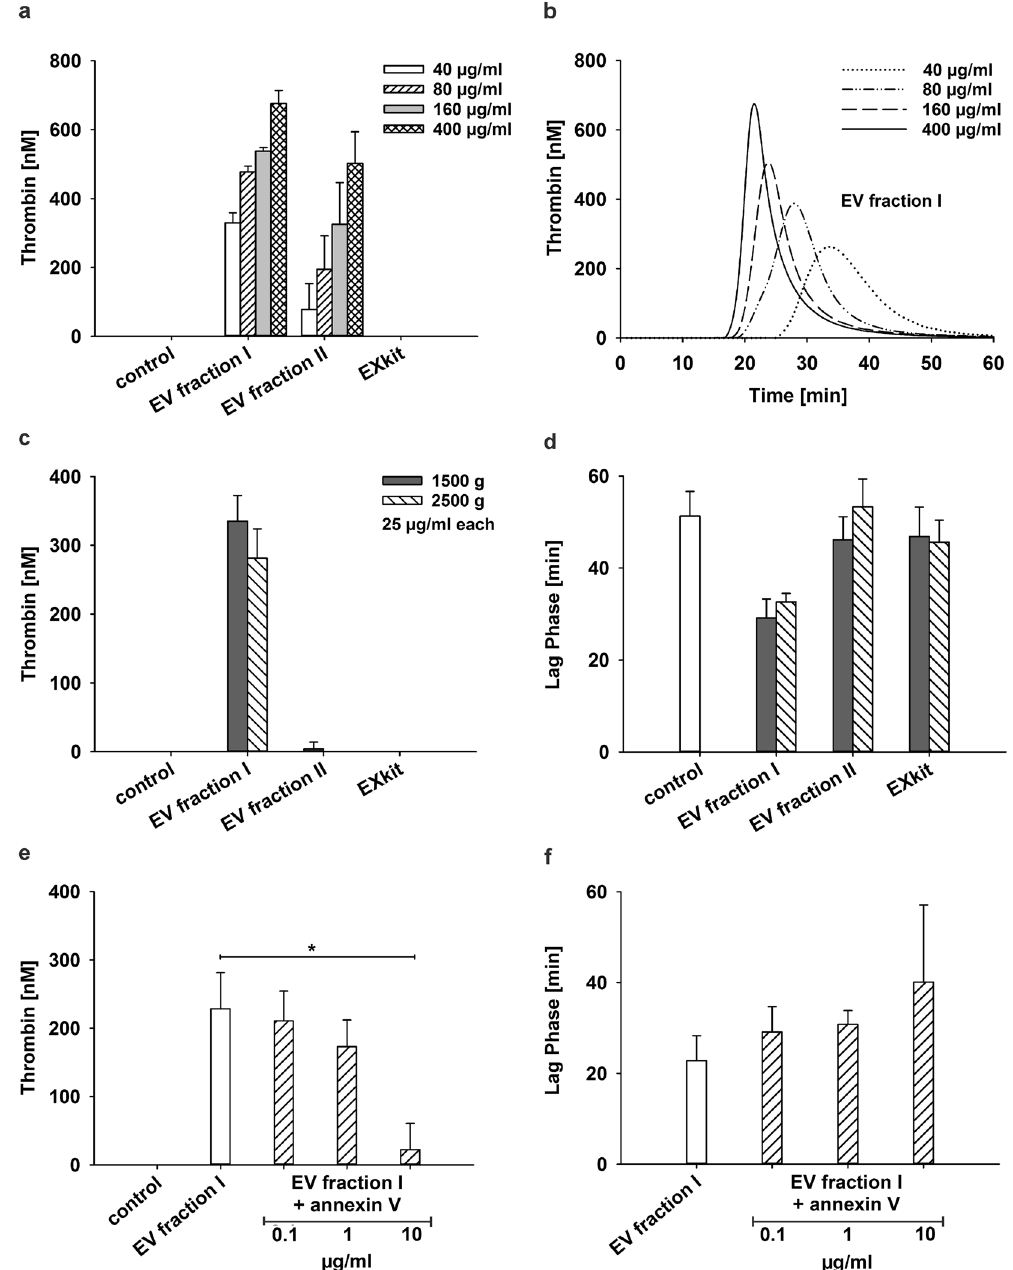
Figure 4. Thrombin generation by platelet-derived vesicle fractions. The thrombogenicity of isolated EVs was studied with a thrombin generation assay. Aliquots of EV suspensions (protein content as indicated in the figure) were incubated with vesicle-free plasma, and the thrombin-dependent cleavage of a fluorogenic substrate was quantified over time as described in the Methods section. ( a ) Thrombin generation after a 60 min incubation of vesicle-free plasma with increasing amounts of platelet-derived EV fractions I and II in comparison to vesicles isolated with an exosome isolation kit (EXkit). Vesicle-free plasma served as control (n = 8); ( b ) Representative curve of dose-dependent kinetics of thrombin generation induced by EV fraction I under the same conditions as shown in panel a; ( c,d ) An increase of the centrifugal force from 1,500 g to 2,500 g to remove residual platelets prior to EV isolation did not affect the amount of thrombin generation nor the lag phase to the onset of thrombin generation (n = 6); ( e,f ) Effect of phosphatidylserine blockade on thrombin generation. Pre-incubation of EV fraction I with annexin V to mask phosphatidylserine decreased thrombin generation in a dose-dependent manner (n = 6); asterisks denote P values ≤